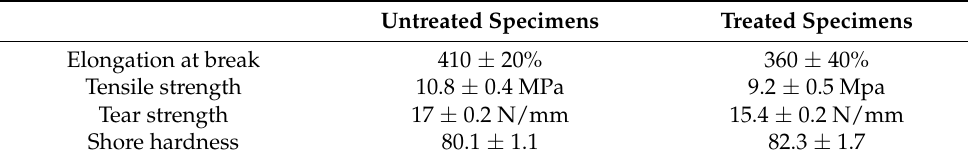
Figure 2. Schematic diagrams of the in situ observation device (not to scale). Table 2. The mechanical properties of the treated FKM specimens.